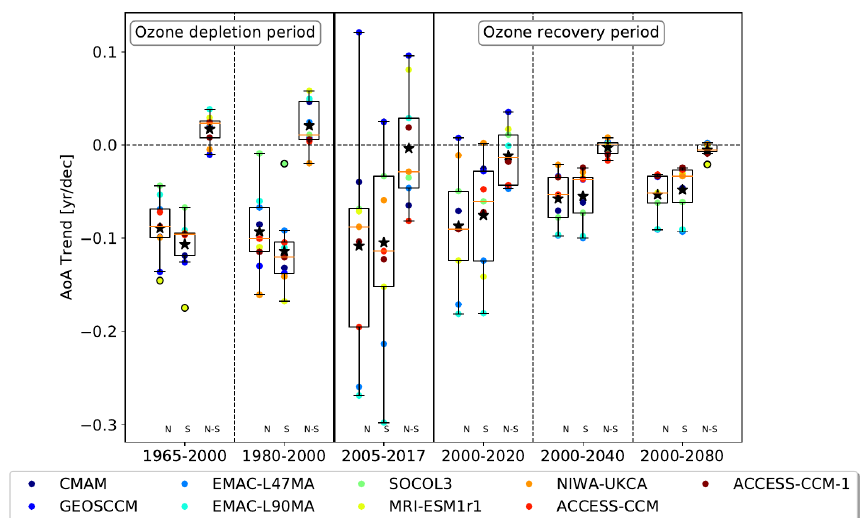
Figure 10. Mean age trends for different periods (see x axis) averaged over 70–10hPa and 20–80 ◦ of each hemisphere, with the left bar in each period displaying the NH trend, the middle bar the SH trend and the right bar the NH–SH difference. Black stars show the multi-model mean, the boxes indicate the lower to upper quartiles, the whiskers show the highest and lowest values, and the orange line shows the median value of the